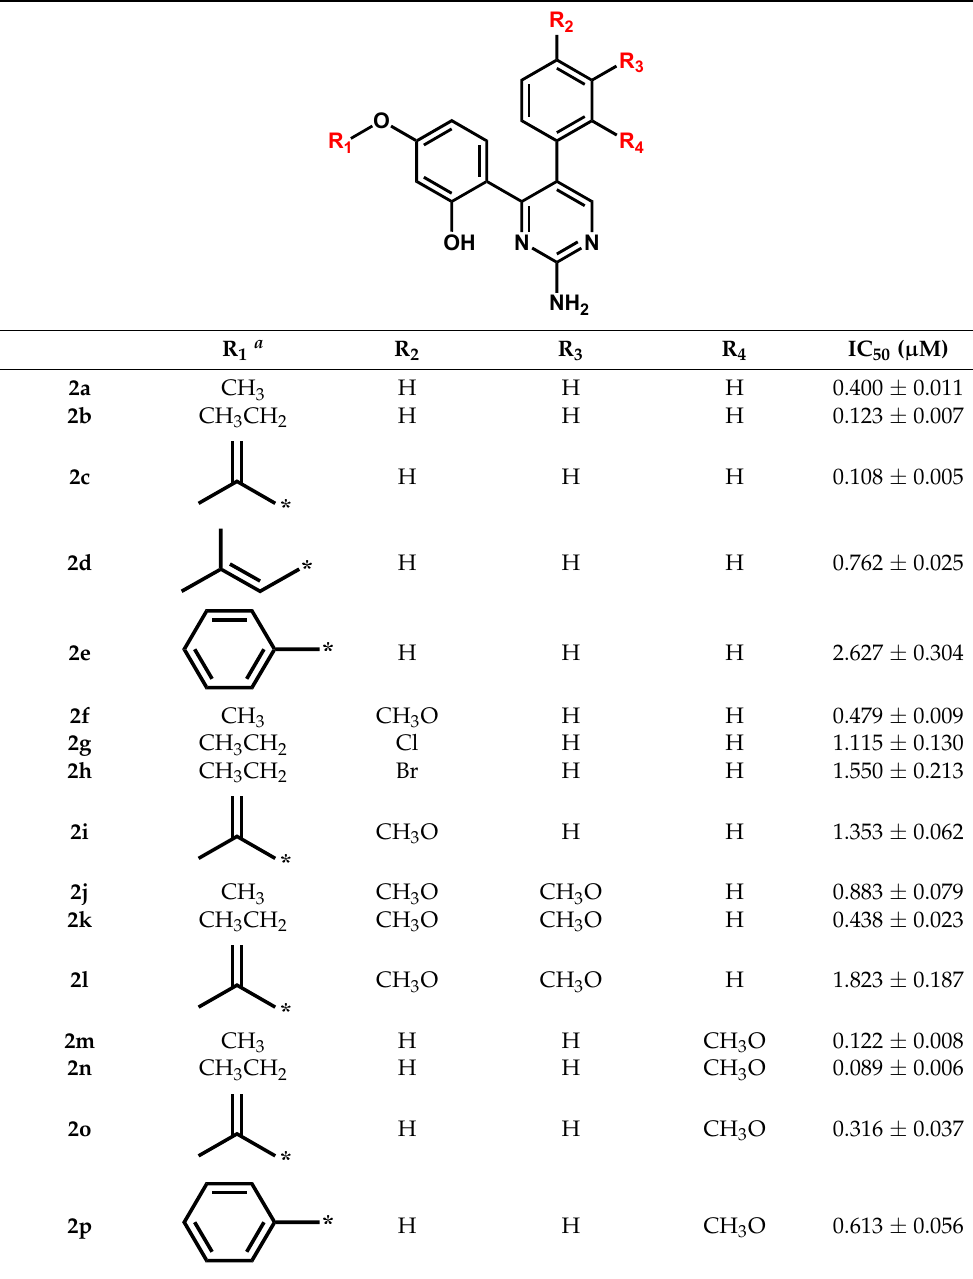
Table 2. Structures and inhibitory activities of the derivatives of Inhibitor 2 against the G2019S mutant.